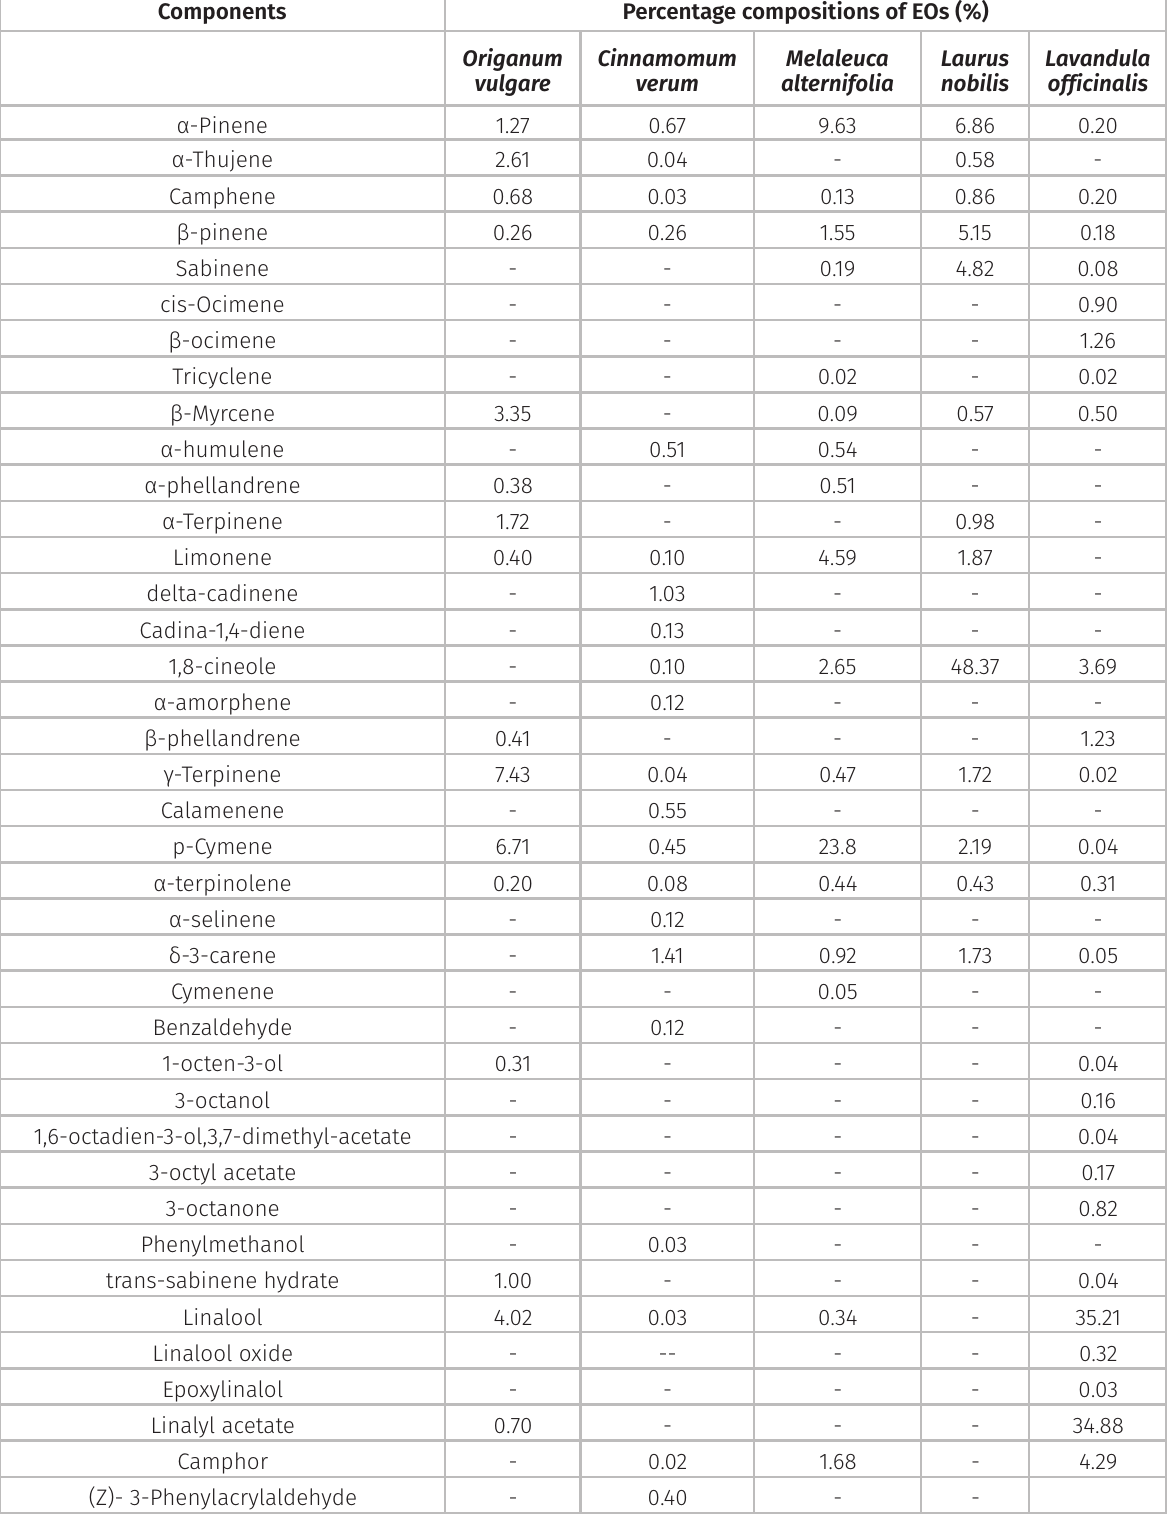
Table I. The components and percentage composition of EOs analysed by-GC-MS.